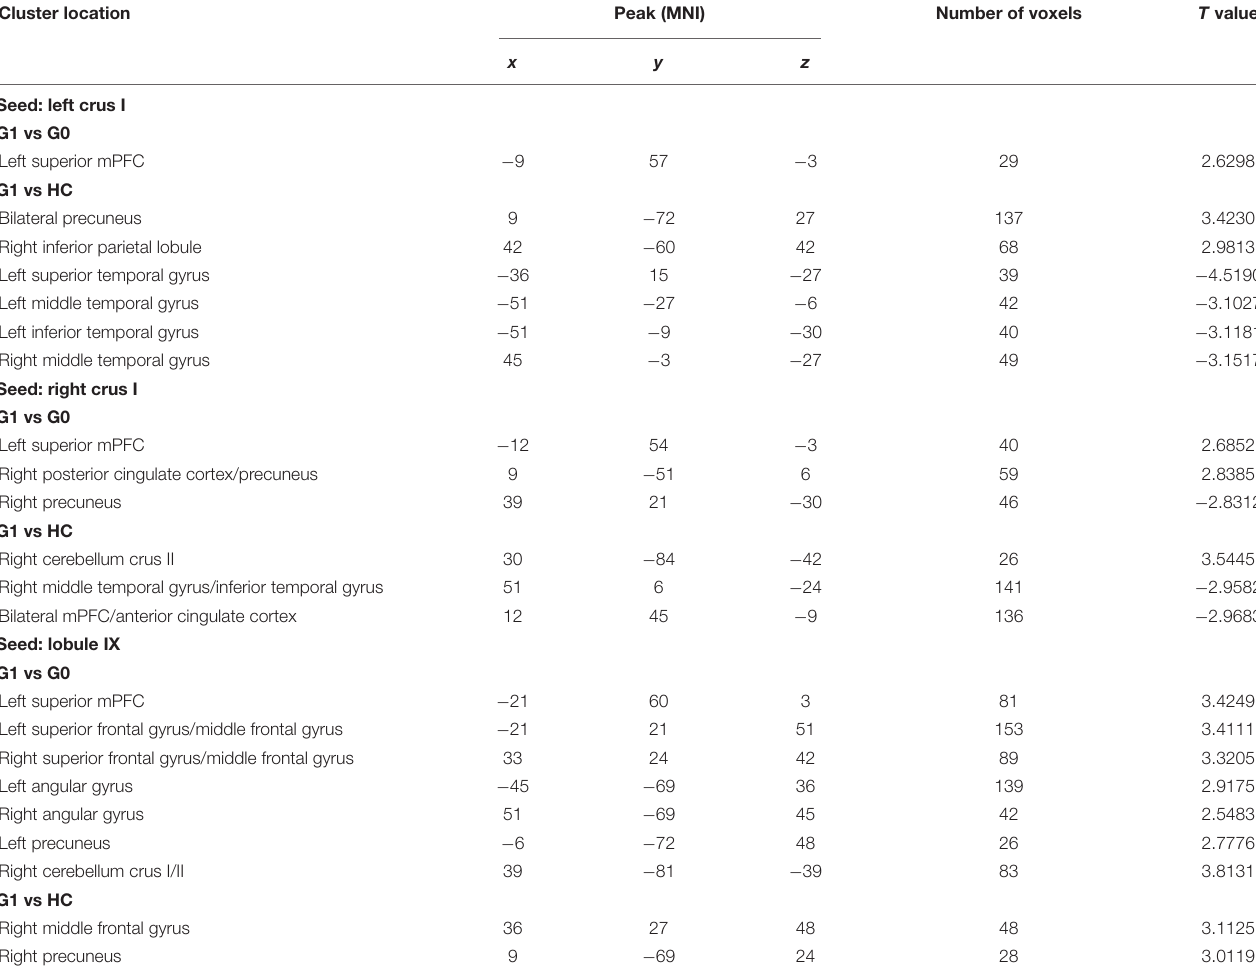
TABLE 2 | Cerebellar functional connectivity differences across the